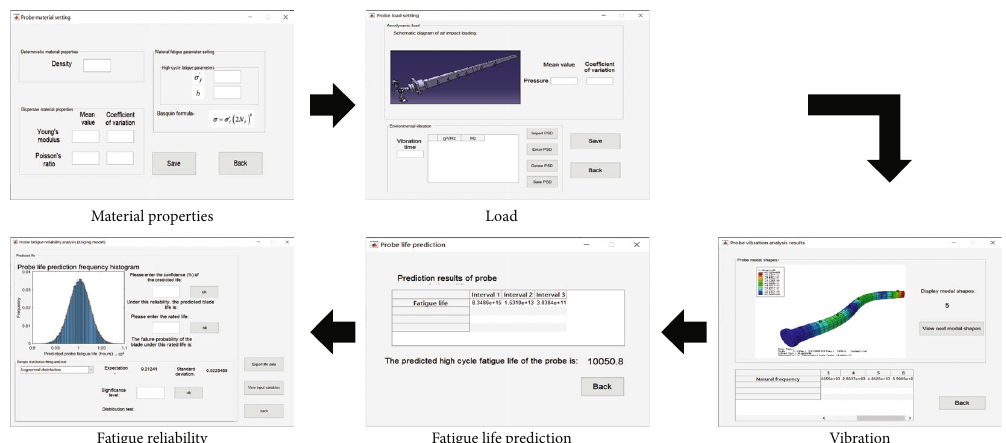
Figure 19: The analysis process for test